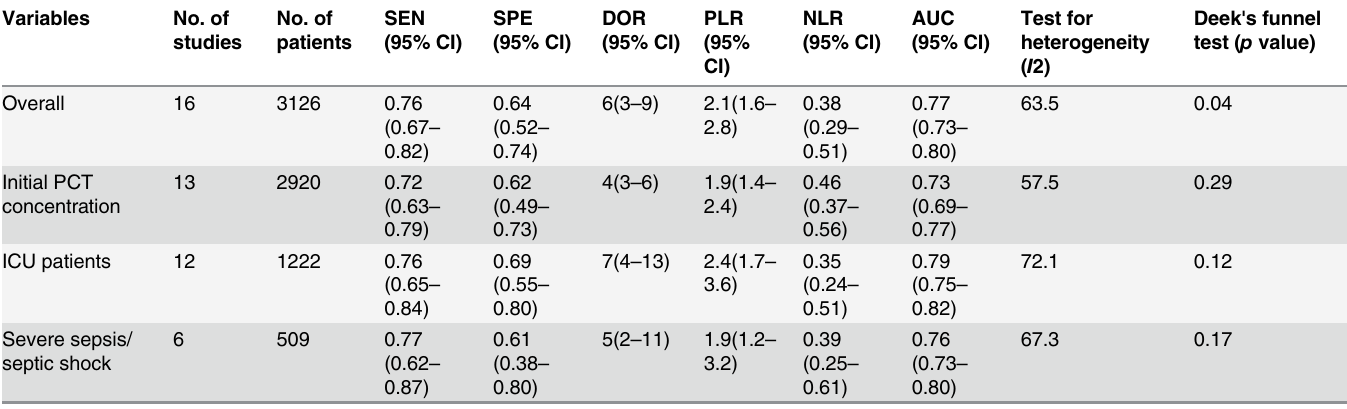
Table 3. Subgroup